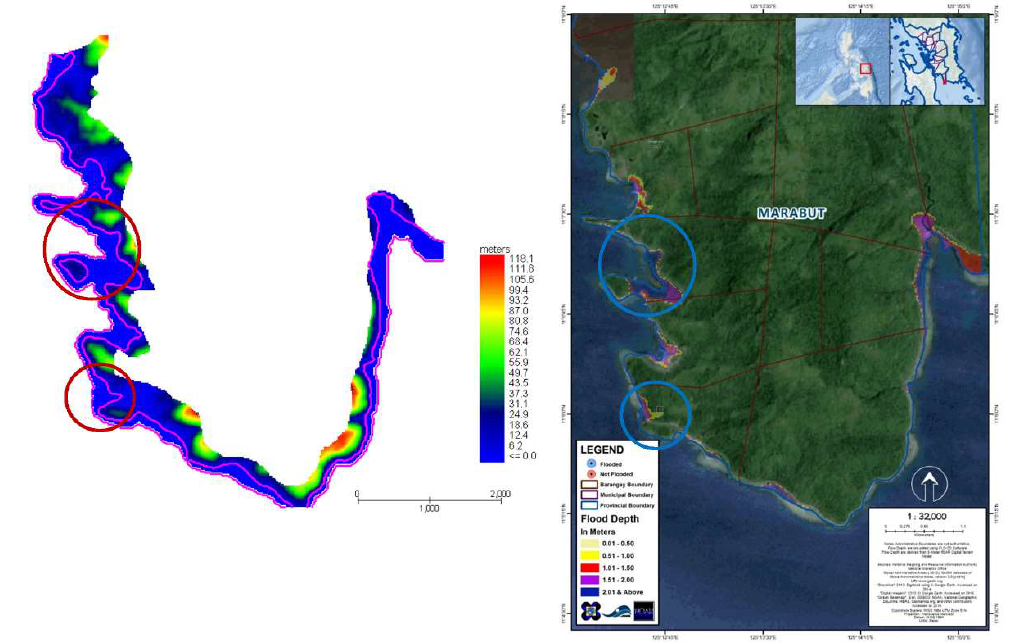
Figure 12. Effect of coastal shape on flow depth and extent in areas with the same elevation (Marabut, Samar). The right panel shows inland inundation, whereas the left panel shows the elevation contour (pink line is flooding extent), proving that the inundated regions (circled areas) are low-lying coasts.